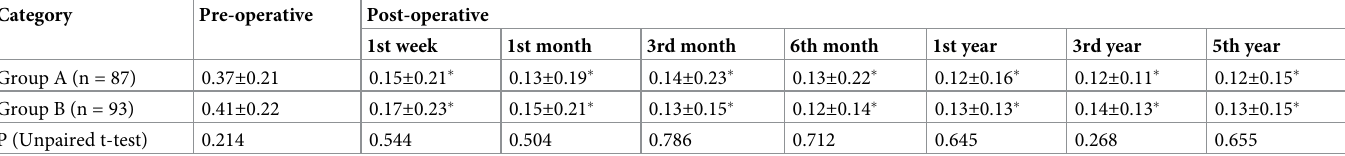
Table 2. Mean CDVA ± SD (logMAR) of Group A (anterior chamber iris-claw fixation) and Group B (retropupillary iris-claw implantation).